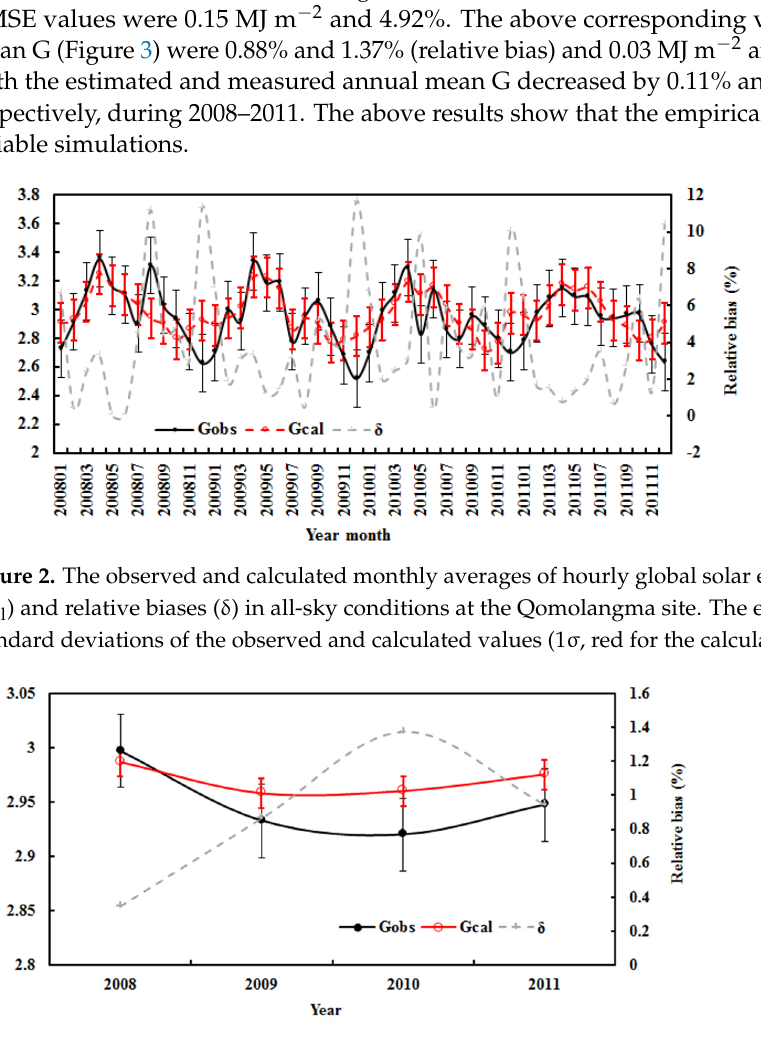
Figure 3. The calculated and observed annual averages of hourly global solar exposure (G obs and G cal ) and relative biases ( δ ) in all-sky conditions at the Qomolangma site. The error bars show the standard deviations of the observed and calculated values (1 σ , red for the calculated values).